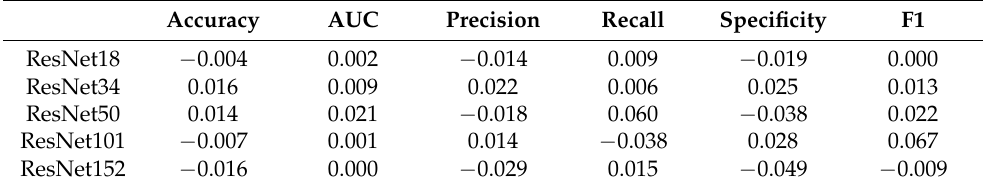
Abbreviations: AUC: area under the curve. The difference was obtained by subtracting the performance of image-only model from the model using clinical patient